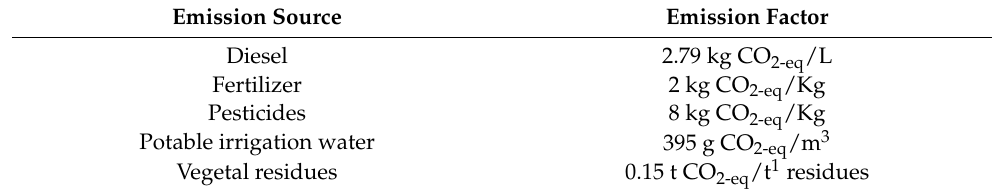
Table 2. Emission factors